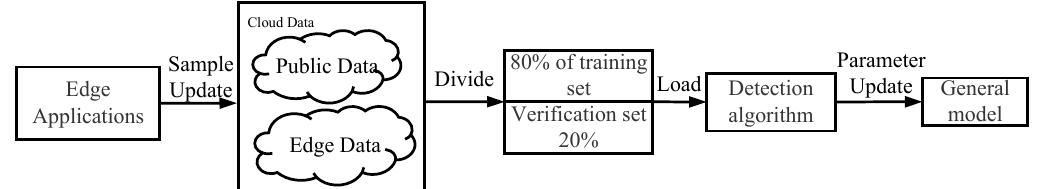
Figure 4. Cloud-based detection model training and update process.